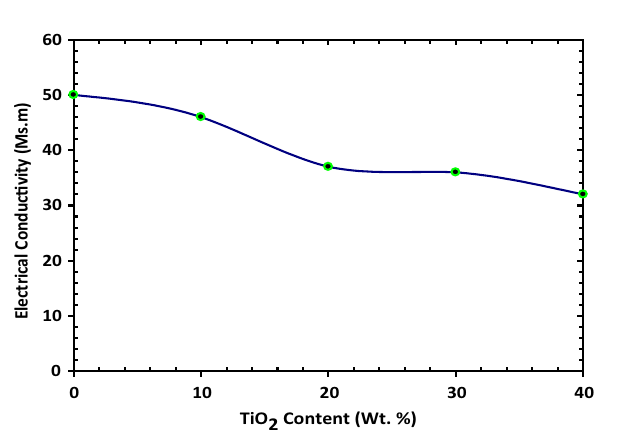
TiO2 Content (Wt. %) Figure 9. Representative the electrical conductivity of Cu–TiO 2 at different percentages 10, 20, 30, and 40 wt.% of